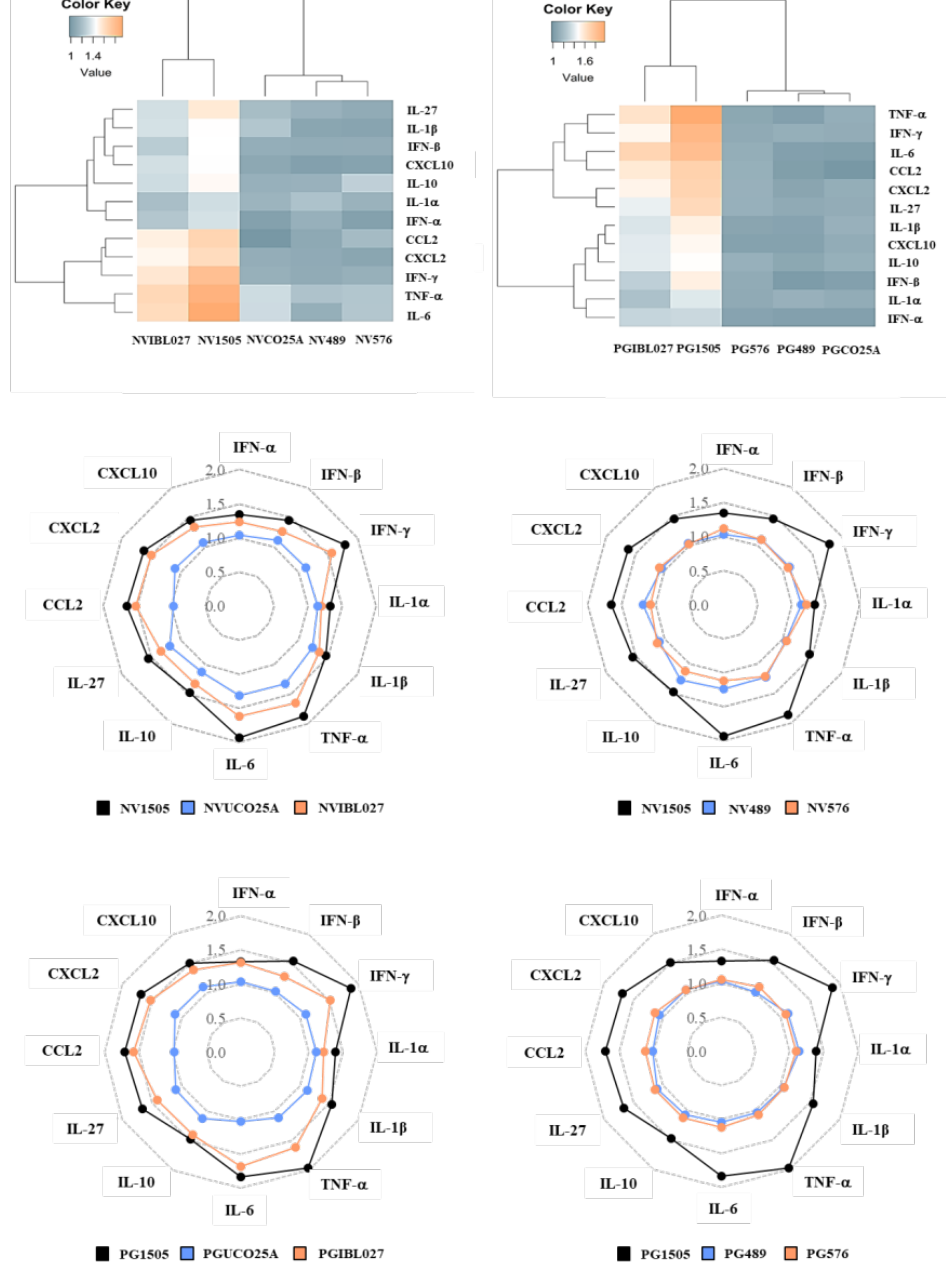
Figure 5. Effect of non-viable (NV) L. rhamnosus CRL1505, CRL498, CRL576, UCO25A and IBL027 and their peptidoglycans (PGs) on alveolar macrophage cytokine profiles in response to secondary S. pneumoniae infection. Infant mice were nasally primed with NVs or PGs for two consecutive days and challenged with the respiratory syncytial virus (RSV). Alveolar macrophages isolated from infant mice were stimulated in vitro with S. pneumoniae . The production of IFN- β , IFN- γ , IL-6 , IL-12 , IL-10 , IL-27 , TNF- α , IL-1 β , CCL2 , CCL3 , CXCL2 and CXCL10 was evaluated in alveolar macrophage culture supernatants after 24 h. The results represent data from three independent experiments. The multiple comparisons of the magnitude of the fold expression changes with respect to the control are shown for the NV1505 vs. NVUCO25A vs. NVIBL027, NV1505 vs. NV489 vs. NV576, PG1505 vs. PGUCO25A vs. PGIBL027 and PG1505 vs. PG489 vs. PG576